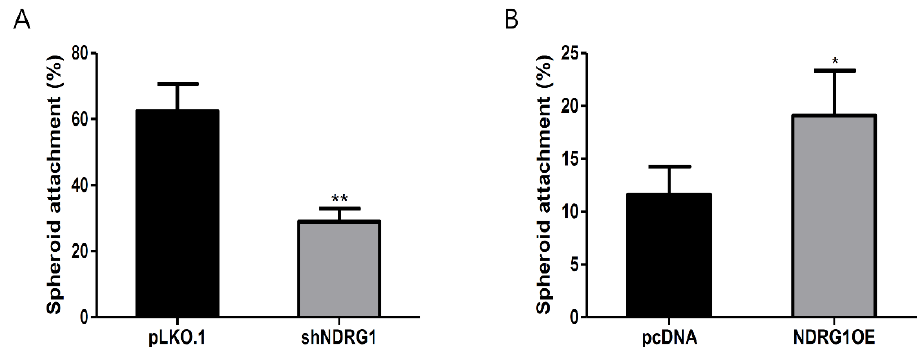
Figure 3. NDRG1 positively affected the attachment of JAr spheroids to endometrial epithelial cells. ( A ) Spheroid-attachment rate to NDRG1-depleted RL95-2 cells. ( B ) Spheroid-attachment rate to NDRG1-overexpressing AN3-CA cells. The data shown represent the mean ± SEM from three inde- pendent experiments (n = 3). * p < 0.05; ** p <